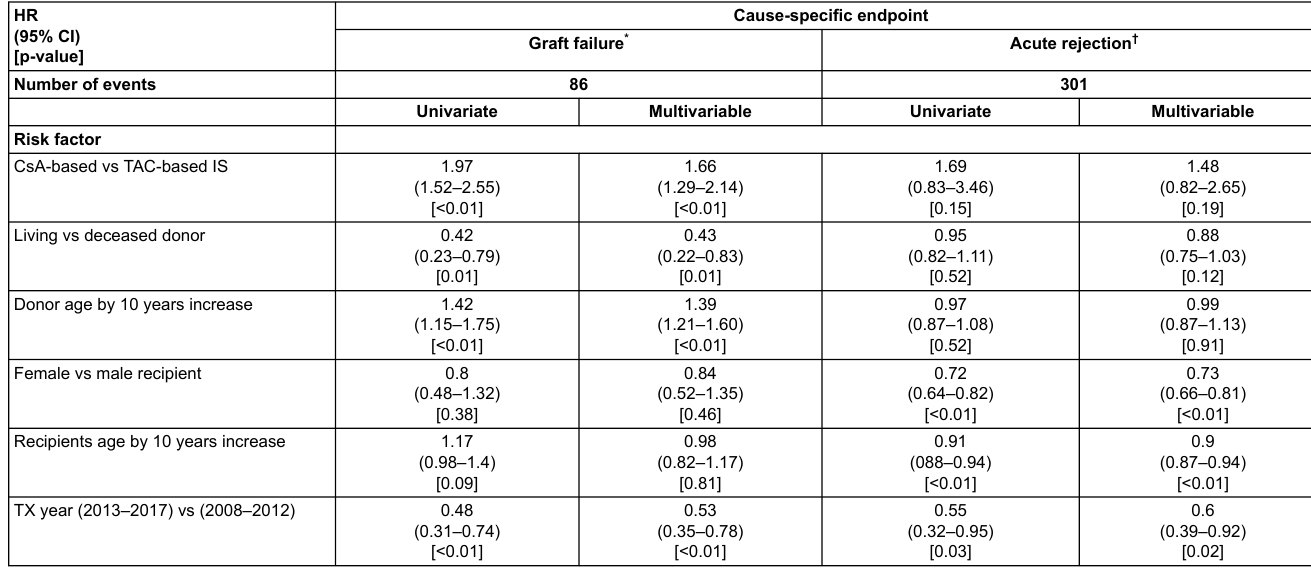
Table 2: Effect estimates from cause-specific Cox proportional hazard models.